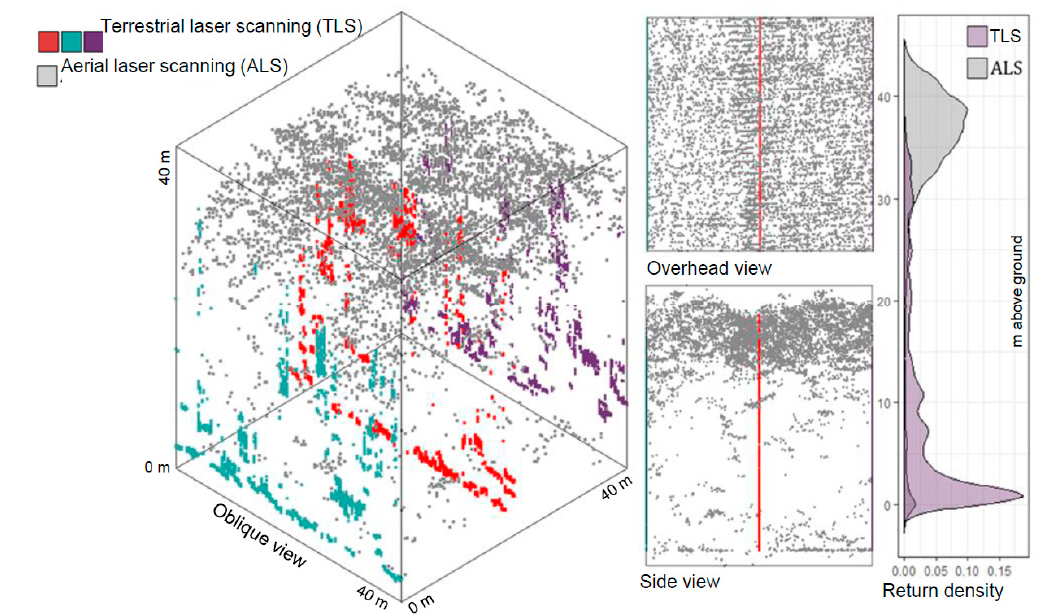
Figure 1. Comparison of aerial laser scanning (ALS) and terrestrial laser scanning (TLS) point clouds for the Great Smoky Mountains site of the National Ecological Observatory Network at plot 053 (40 × 40 m) from oblique, overhead, and side angles. Vertical profiles of return heights from raw LiDAR returns demonstrate the occlusion experienced by both LiDAR methods as a result of their respective view angles (return density refers to the proportion of total points or relative densities of returns from each platform).